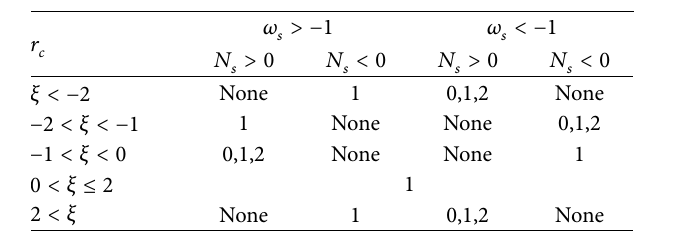
Table 2: Real root 𝑟